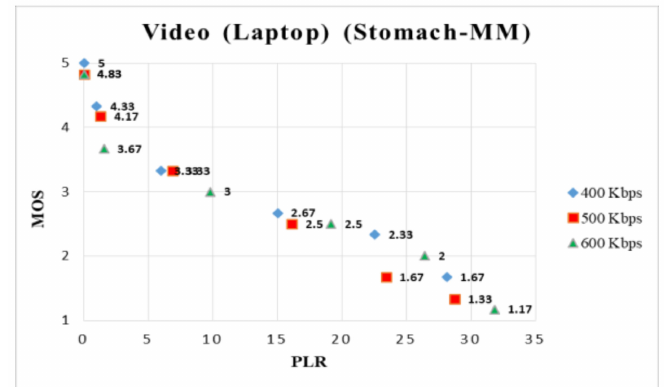
Figure 8. MOS ratings for stomach ultrasound (MM) on laptop.